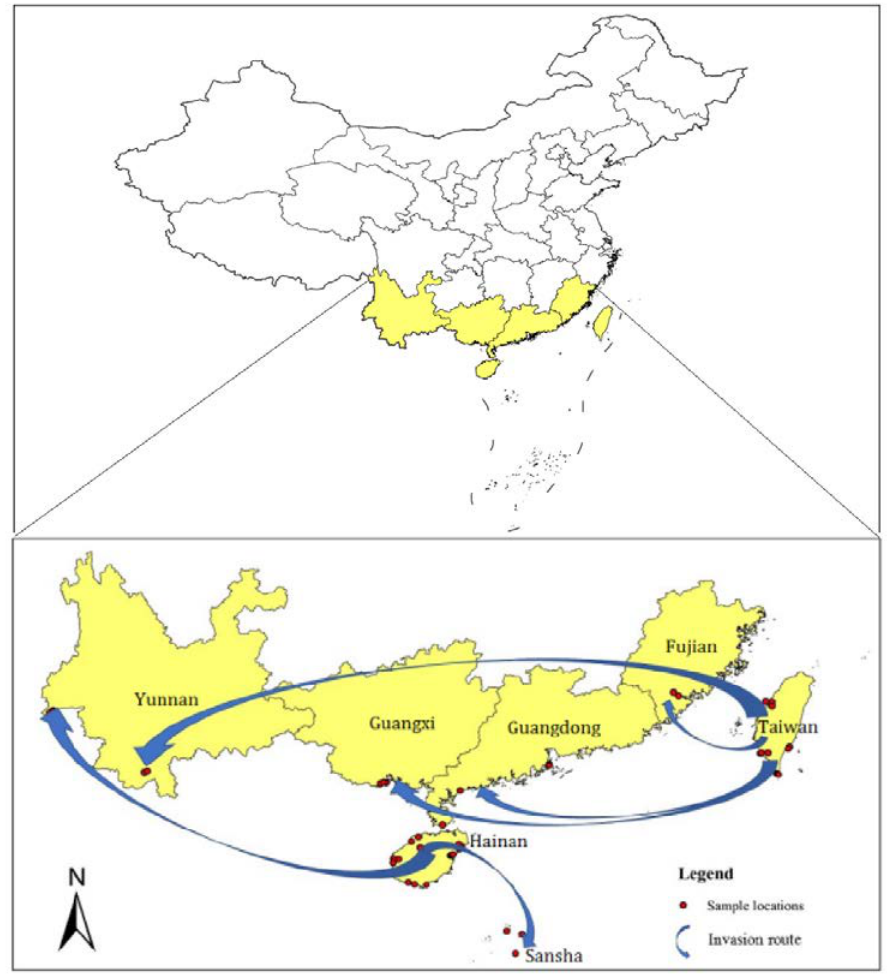
Figure 1. Map of coconut leaf beetle, B. longissima sampling locations and inferred invasion routes.